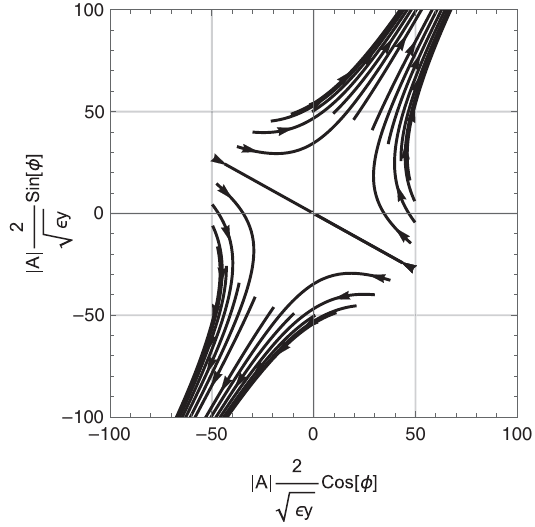
FIG. 15. Evolution of the average particle trajectories, solu- tion of Eqs. (A4) and (A5) with the same initial ampli- tude and different initial phases. Initial amplitude corresponds 0 Þ ¼ 50 σ to y 0 ð φ y ¼ y